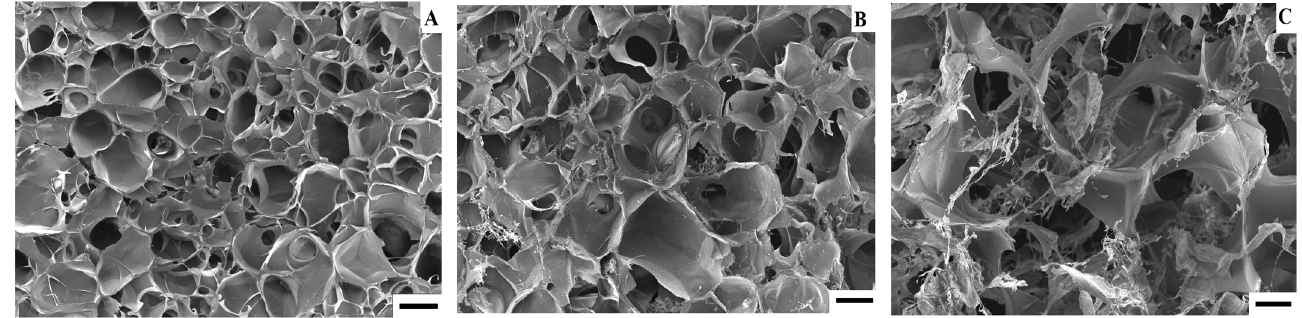
Figure 3. SEM of GelHACS-10 ( A ), GelHACS ( B ) and GelHACS ( C ) cryogels. Scale bar = 100 μ m. Changes in the content of HA also affected their osmotic characteristics (swelling extent) of cryogels. The swelling results are shown in Figure 4. The maximum degree of swelling is reached in 24 h. Since cryogels can absorb large amounts of aqueous solutions or liquids and effectively support cell infiltration, this should promote both enzymatic and non-enzymatic degradation [26,51]. Studies have shown that the highest degree of swelling is observed in the GelHACS-50 cryogel (22.7 ± 0.5%), while GelHACS-10 cryogel exhibited the lowest degree of swelling (15.9 ± 1.0%) (Figure 4). As is known, the less the cryogel network is crosslinked, the faster it swells [52]. The SEM results showed that the GelHACS-50 sample has open and large pores with fewer crosslinks, thus it can hold a large amount of liquid in the cryogel spatial network. While GelHACS10 cryogel has smaller pores and a high degree of crosslinking, thereby reducing liquid sorption in the polymer network.